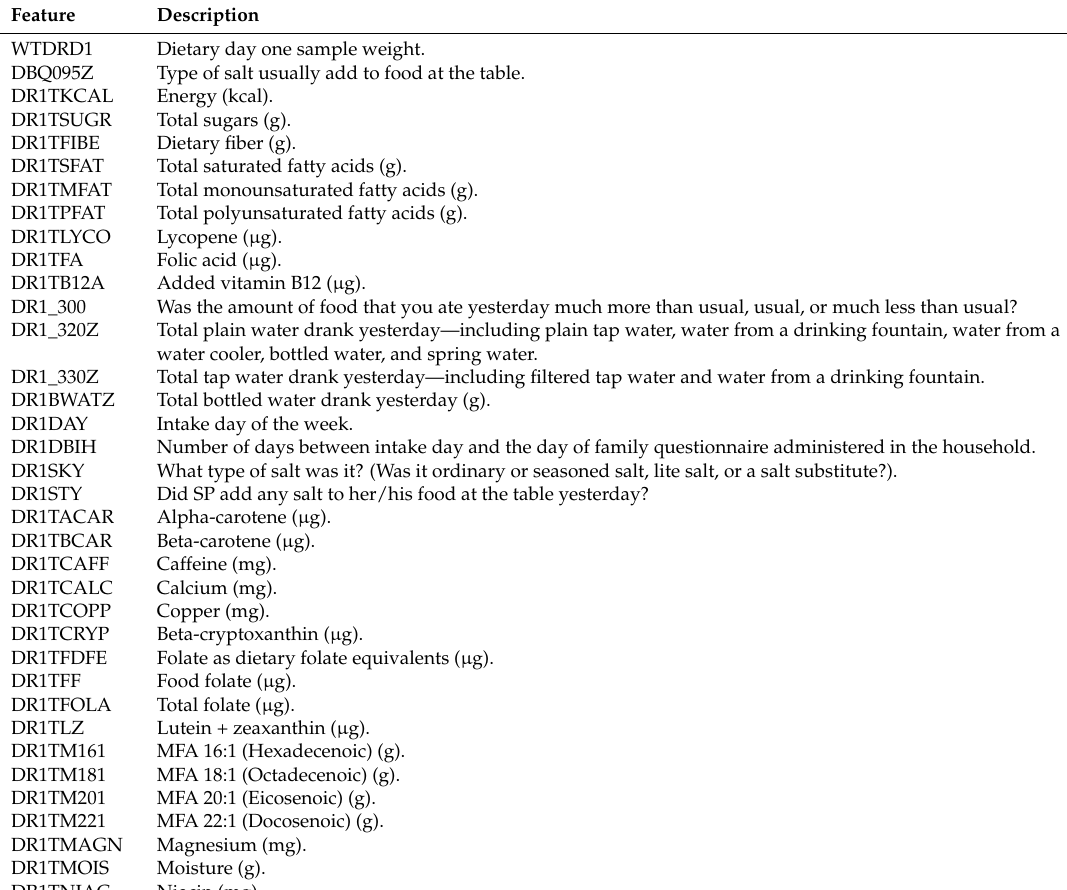
Table A2. Description of dietary